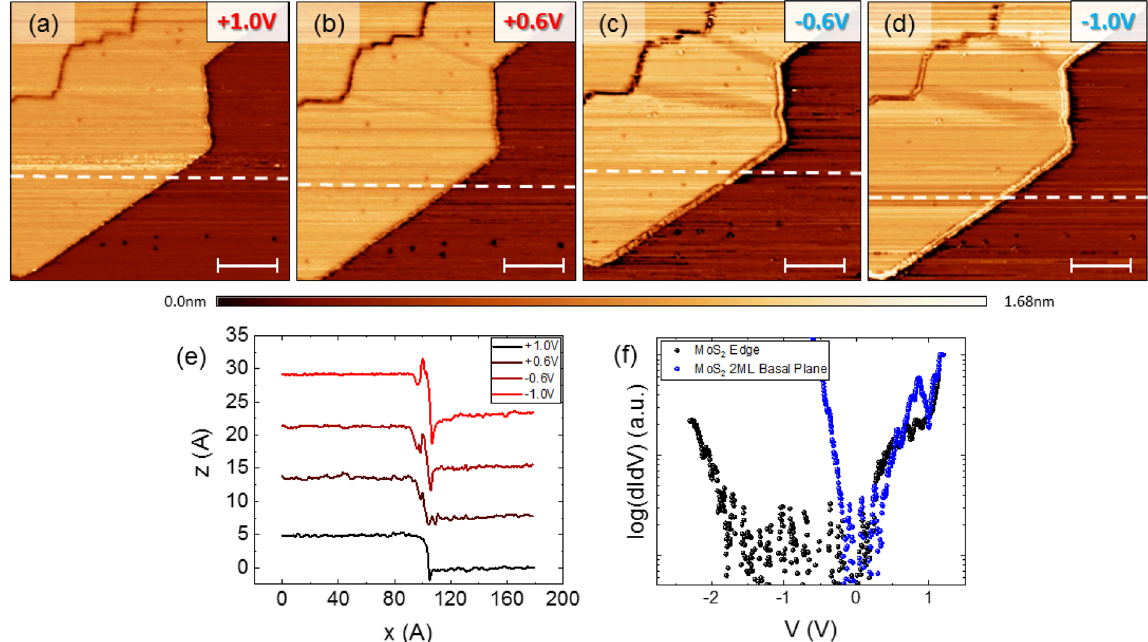
Figure 3. STM/STS on the edge of a bilayer MoS 2 island. ( a – d ) Energy dependent STM topography of the edge of a bilayer island sitting on monolayer MoS 2 (with tunneling bias displayed in the upper right corner of each topography (I = 30 pA, 30 pA, 60 pA and 80 pA, respectively). All scale bars represent 50 nm. ( e ) Topographic line profiles as a function of energy taken along the dashed line in ( a – d ). Representative STS taken on the basal plane (black) and the edge (blue) of the bilayer island shown in ( a ) (V = 1.5 V, I = 30